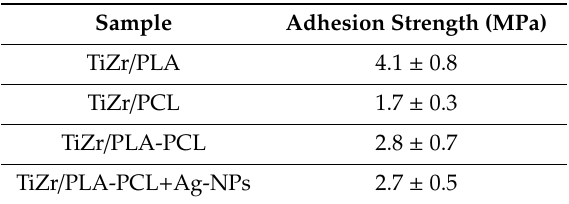
Table 5. Adhesion strengths of the coatings on